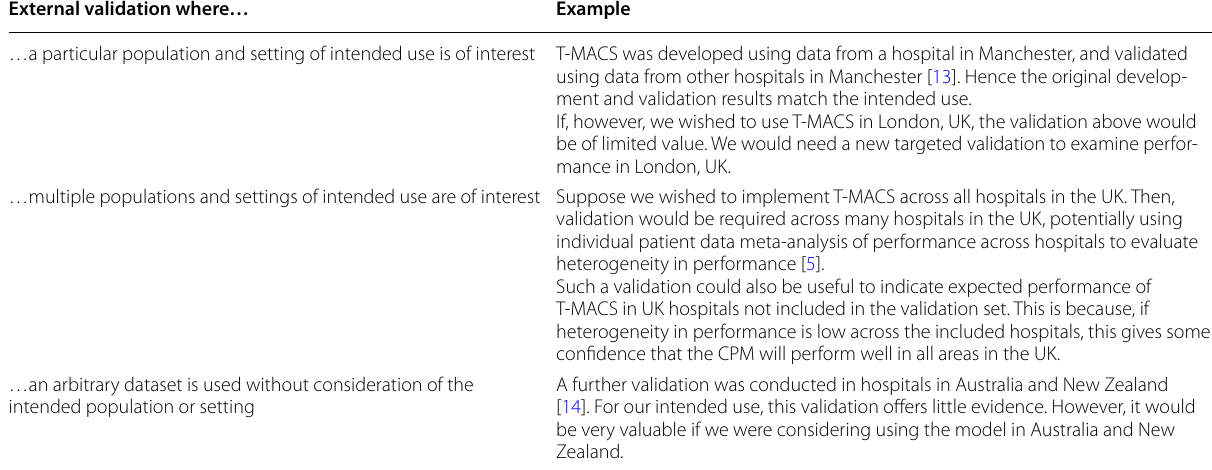
Table 1 Consider T-MACS—a CPM developed for the prediction of acute myocardial infarction in patients presenting to the emergency department with chest pain [13]. Suppose our intended use is initially for hospitals within the Greater Manchester (UK) area, and then we are considering rolling out the CPM across the UK External validation